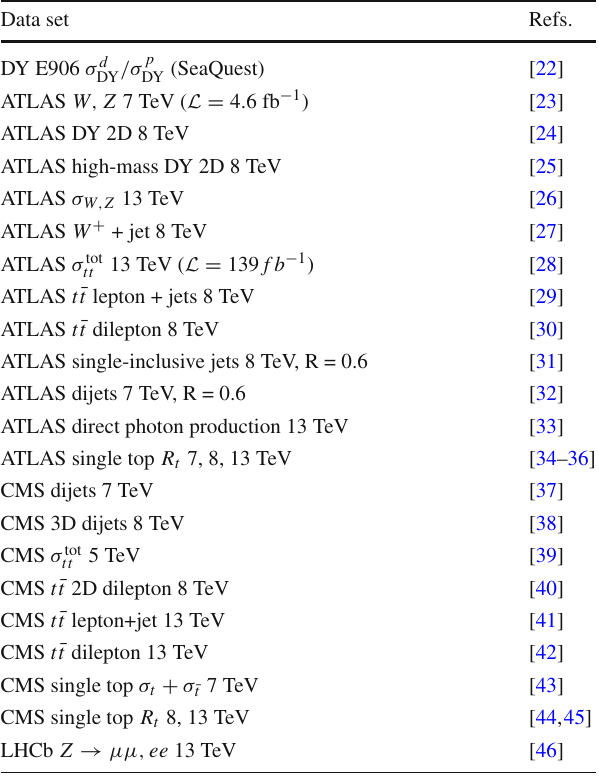
Table2 Observablesincludedinthetestdata.Wewishtostressthatthe observable central values themselves are not used, however the experi- mental uncertainties are used in the definition of the closure estimators, and the corresponding predictions from either the underlying law or the closure fits Data set Refs.